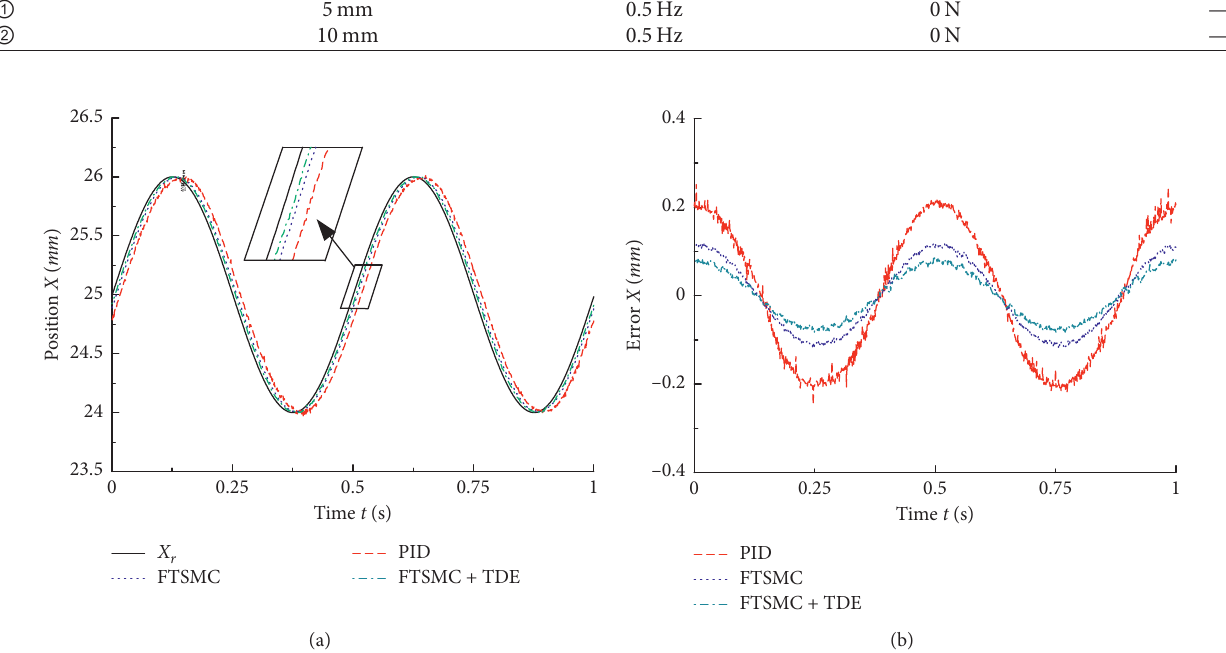
Figure 8: Working condition ① in Table 4. (a) Position of 1 mm amplitude and 1 Hz frequency. (b) Position error of 1mm amplitude and